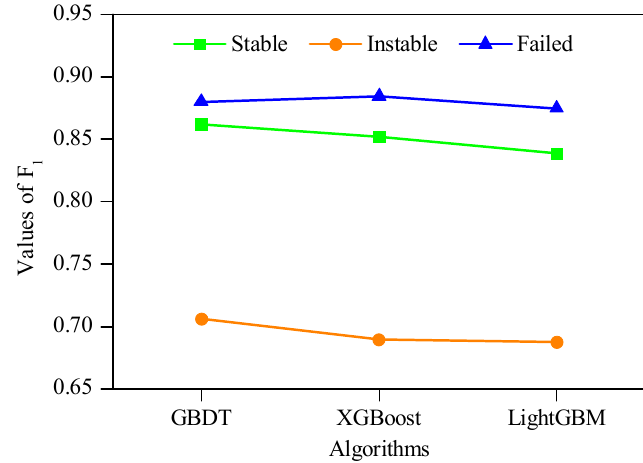
Figure 10. F 1 values of each algorithm for each stability level.